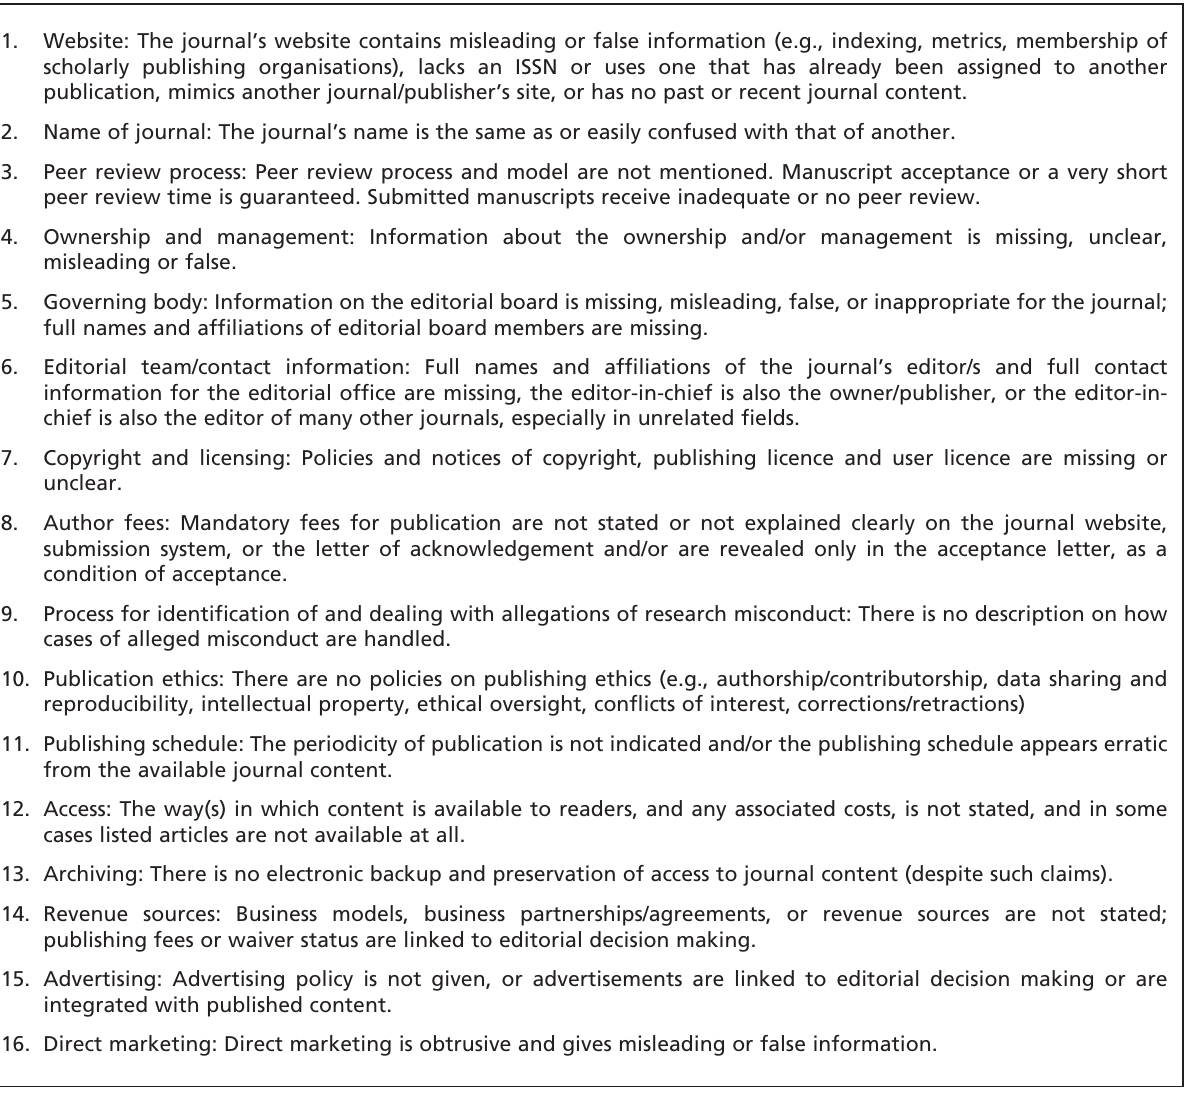
Warning signs of fake journals, based on the 16 principles of transparency Table I: